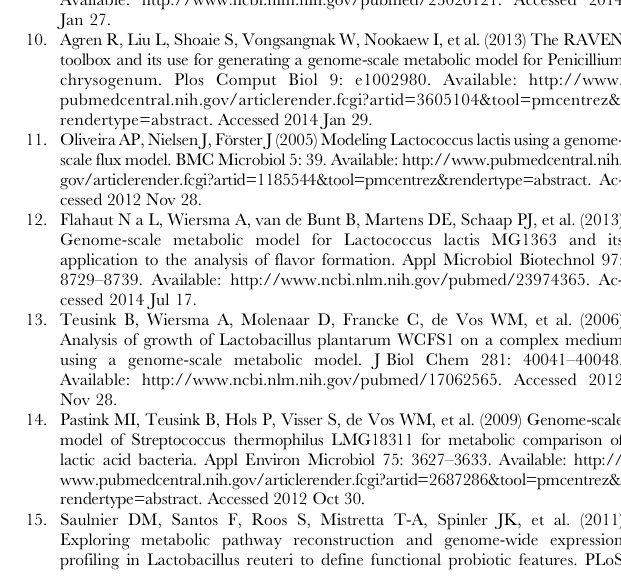
Table S4 Type of gene deletion sets, with glucose or galactose and all amino acids, found in i Lca12A_640 and